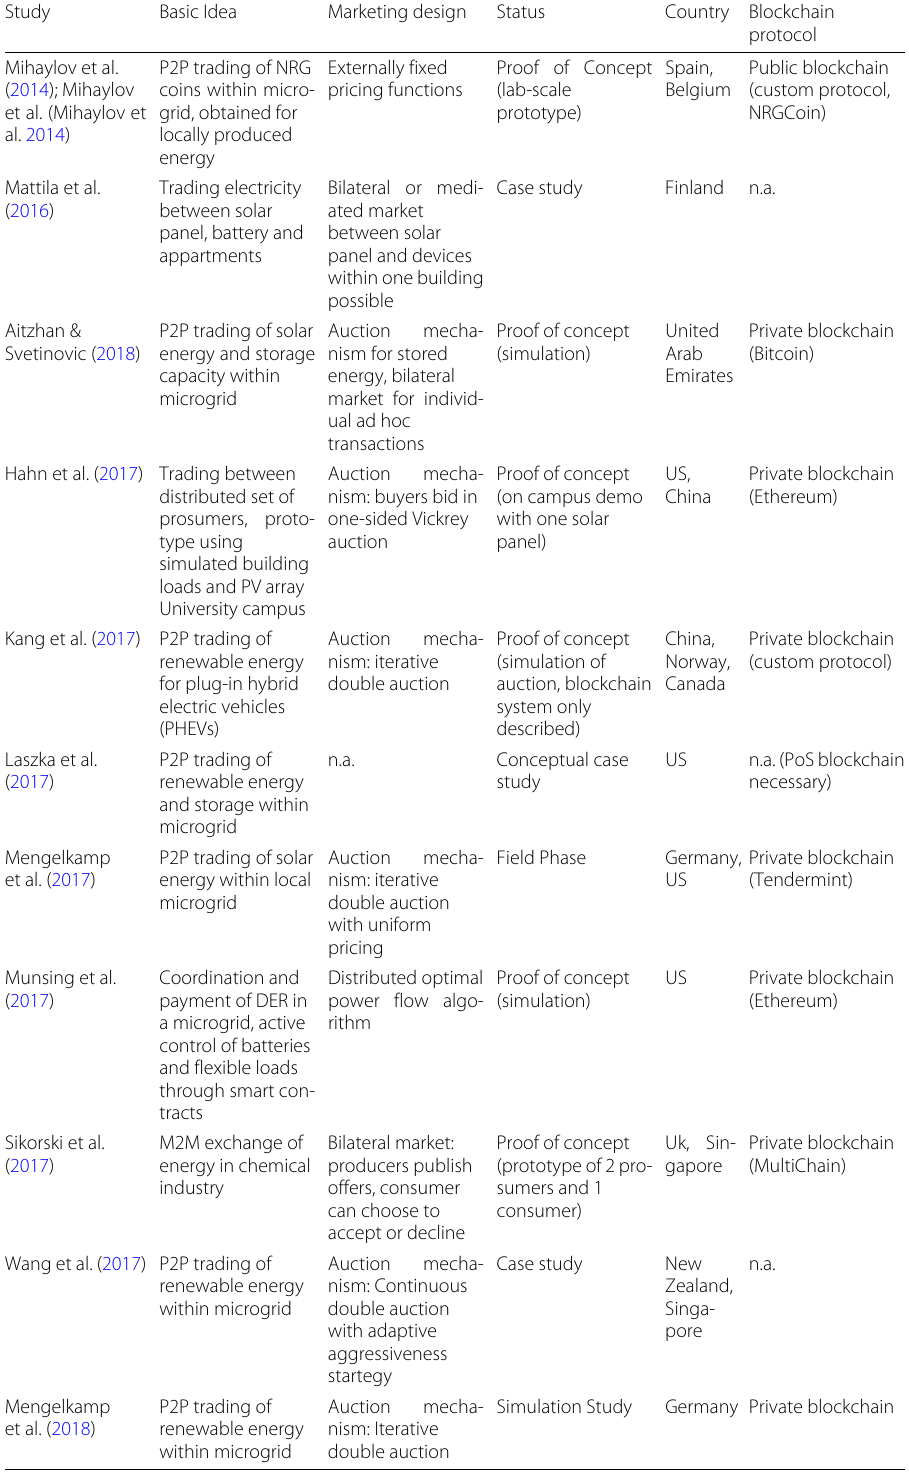
Table 1 Relevant scientific articles discussing blockchain-based energy markets Study Basic